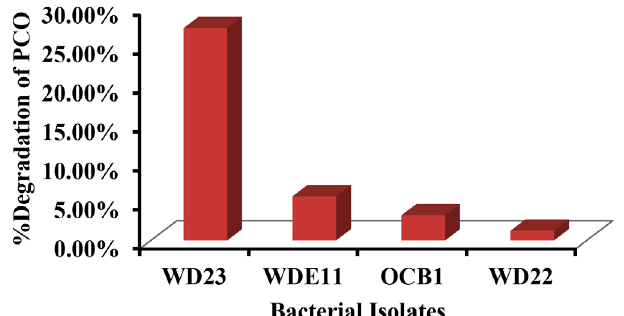
Fig. 6. Degradation of PCO by bacterial isolates in sea water supplemented with PCO, glucose and yeast